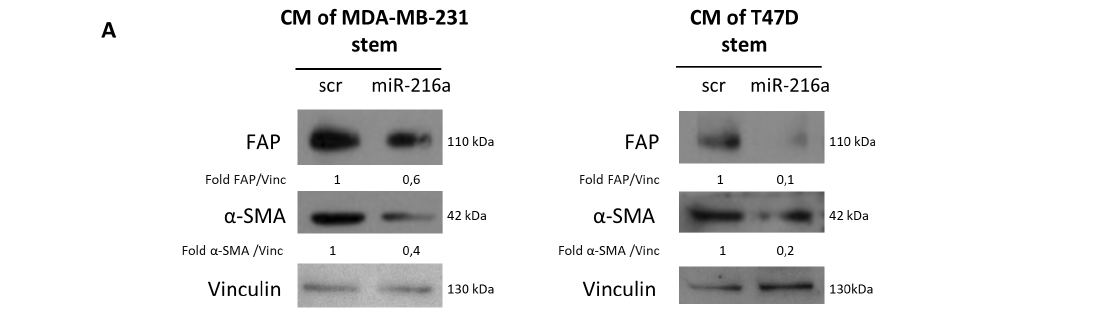
Figure 5. Effect of MiR-216a on cancer-associated fibroblasts (CAFs) and normal fibroblasts (NFs). ( A ) CAFs were treated with conditioned media collected from MDA-MB-231 and T47D stem cells overexpressing miR-216a. MiR-216a reduces CAF activation compared to the negative control. ( B ) Differentiated MDA-MB-231 and T47D cells transfected with anti-miR-216a upregulates CAF markers